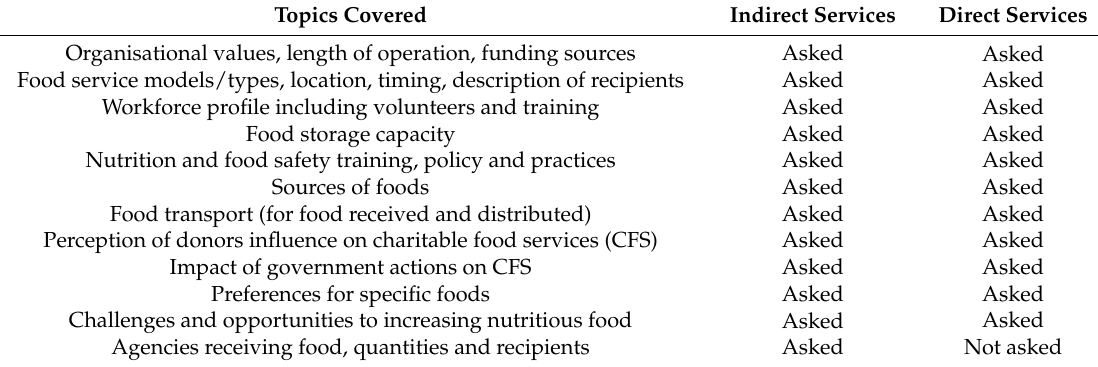
Table 1. Semi-structured interview schedule. Topics Covered Indirect Services Direct